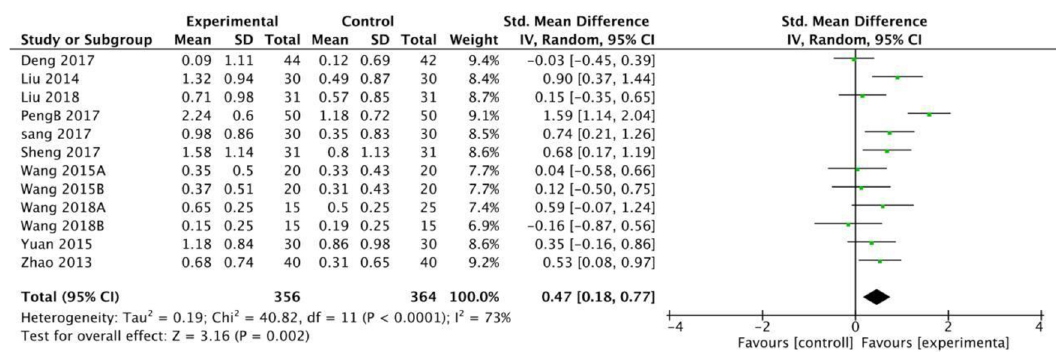
Fig 5. Meta-analysis of fire acupuncture versus acupunture for spasticity after in MAS.